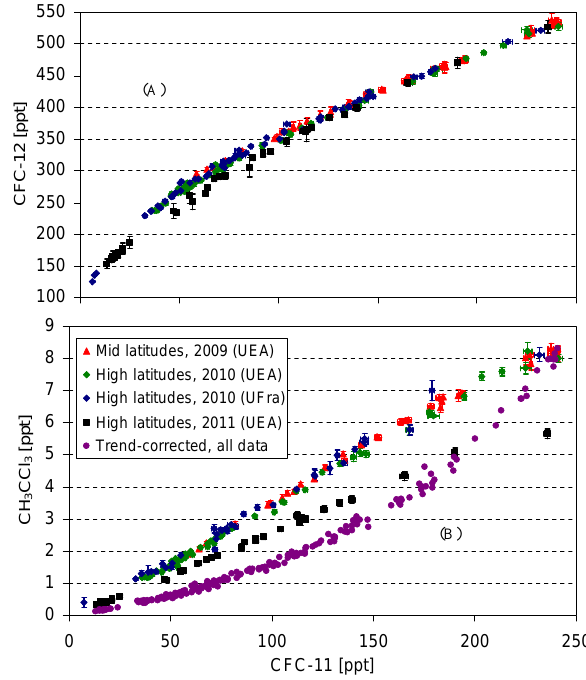
Figure 2. Compact correlations of CFC-11 mixing ratios with those of CFC-12 (A) and CH 3 CCl 3 (B) in the mid- and high latitude stratosphere as obtained from whole-air samples collected during aircraft campaigns in 2009 (red), 2010 (blue and green) and 2011 (black). Analysis of the 2010 samples was split between the University of Frankfurt (UFra, blue) and the University of East Anglia (UEA, green) with excellent agreement between the two data sets for all compounds. When applying a first-order correction for the influence of the changing tropospheric trend the correlations become very similar (purple). This is only displayed for (B) as the respective changes in tropospheric abundances of CFC-11 and CFC-12 are small and thus the “trend-corrected” correlation is almost indistinguishable from the other correlations.